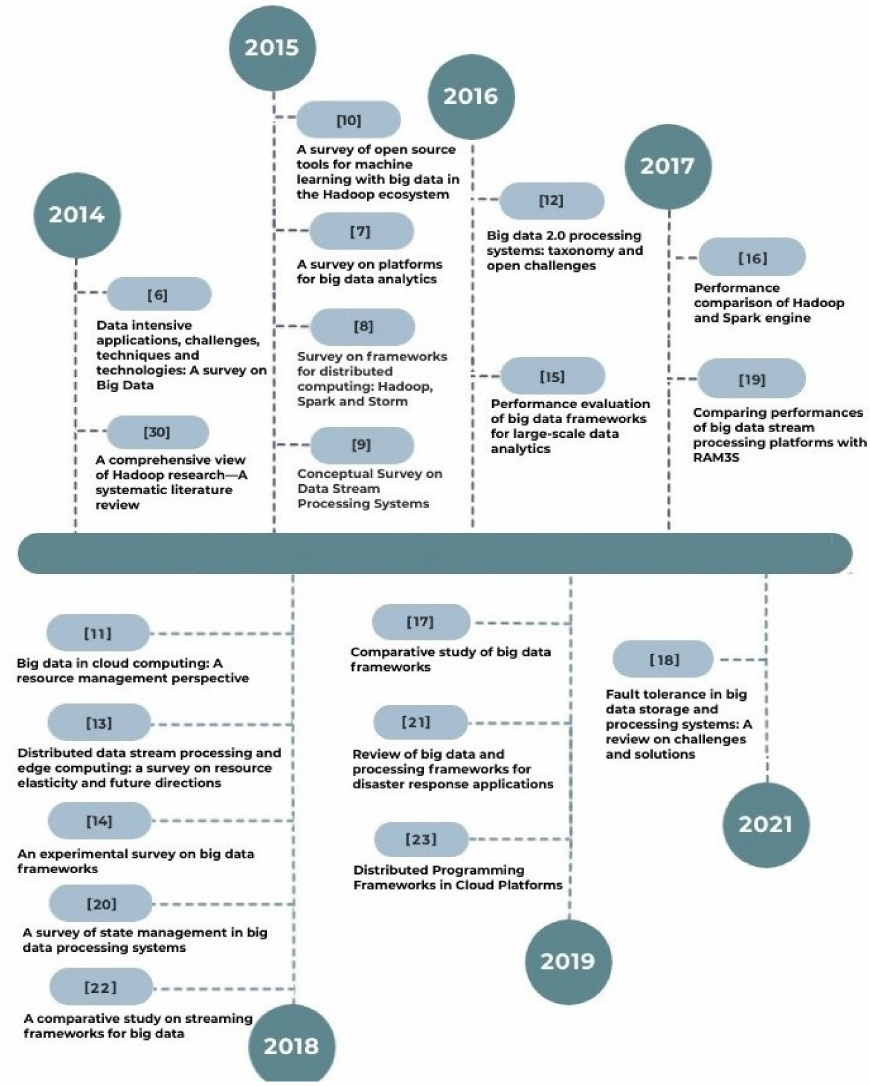
Figure 3. A timeline view of the research works reviewed. Gupta and Parveen [17] surveyed popular big data frameworks on the basis of a few primitive parameters. Saadoon et al. [18] highlighted common problems and potential solutions related to fault tolerance in big data systems. The study presented a thorough discussion based on the findings derived from existing studies. Bartolini and Patella [19] conducted a study that used sustainable input rate as a measure of efficiency to compare big data frameworks. Authors empirically proved that Storm outperformed both Flink and Spark in local cluster setting as well as in cloud environment. In [20] authors focused state management techniques in big data systems such as Flink, Heron, Samza, Spark, and Storm. Cumbane [21] reviewed big data frameworks for disaster response applications. This research also discussed the similarities and differences of big data frameworks. However, the focus of the study revolves around the application of big data systems in the response phase of a disaster. Inoubli et al. [22] surveyed popular stream processing frameworks and an experimental evaluation of resource consumption. Patil [23] discussed big data frameworks and empirically compared Spark and Flink with TeraSort benchmark using execution time, network usage and throughput as performance